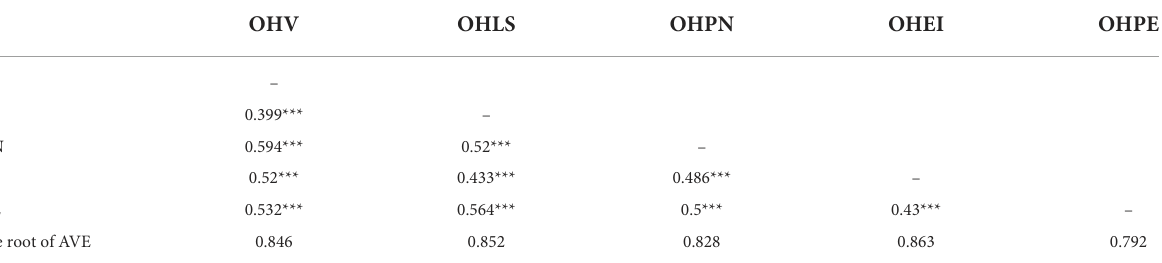
TABLE 4 Correlations between factor structures in study